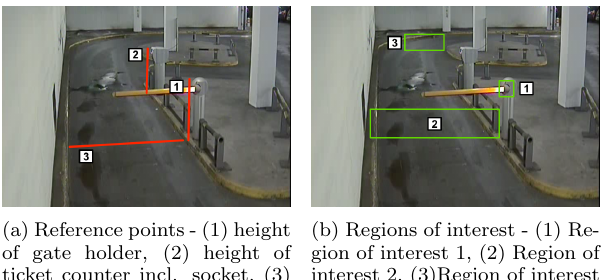
Figure 1: Initialization, setting of reference objects - car park entrance (P01 - Airport car park entrance) The measurement process of vehicle size implies two funda- mental challenges: 1) the estimation of the correct timing of the measurement process and 2) the robust estimation of vehicle’s width and